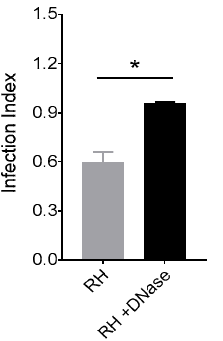
Figure 5. NET decreases T. gondii infectivity to host cells. Tachyzoites of RH strain were incubated in NET-enriched supernatants pretreated or not with DNase for 30 min. Parasites were further used to infect Vero cells (1:1 parasite:Vero ratio) for 180 min, and the infection index was determined after 21 h culture. Data from two independent experiments are shown as mean (SD). * p < 0.05.